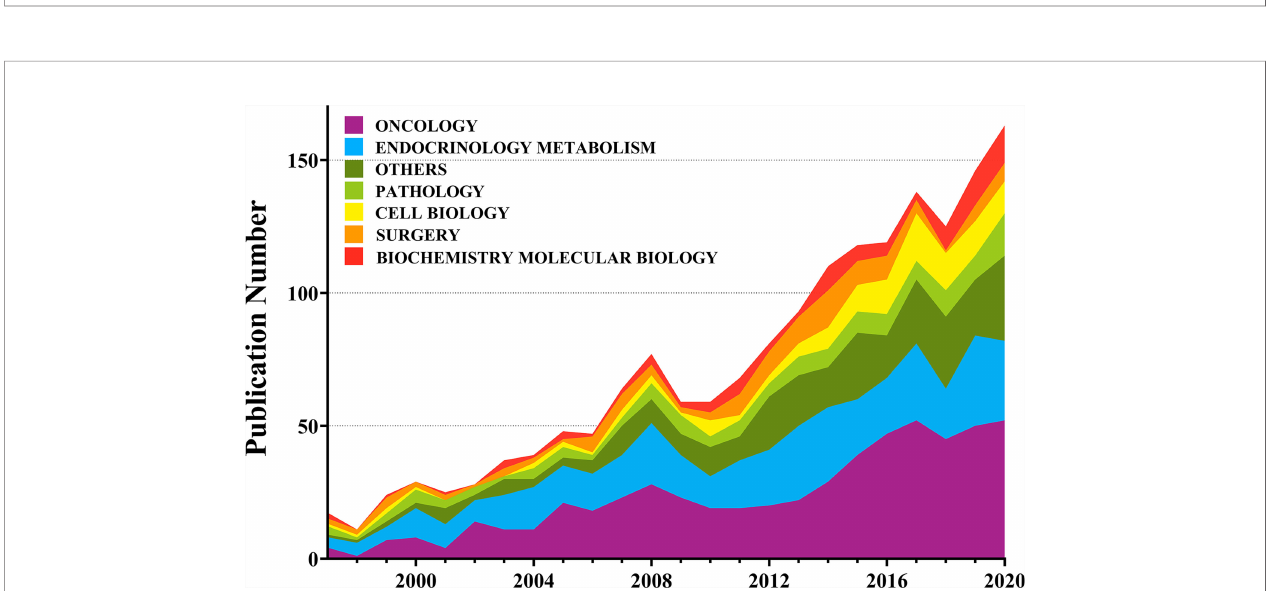
FIGURE 2 | Quantity and growth trend of annual publications in ATC publications from 1997 to 2020.